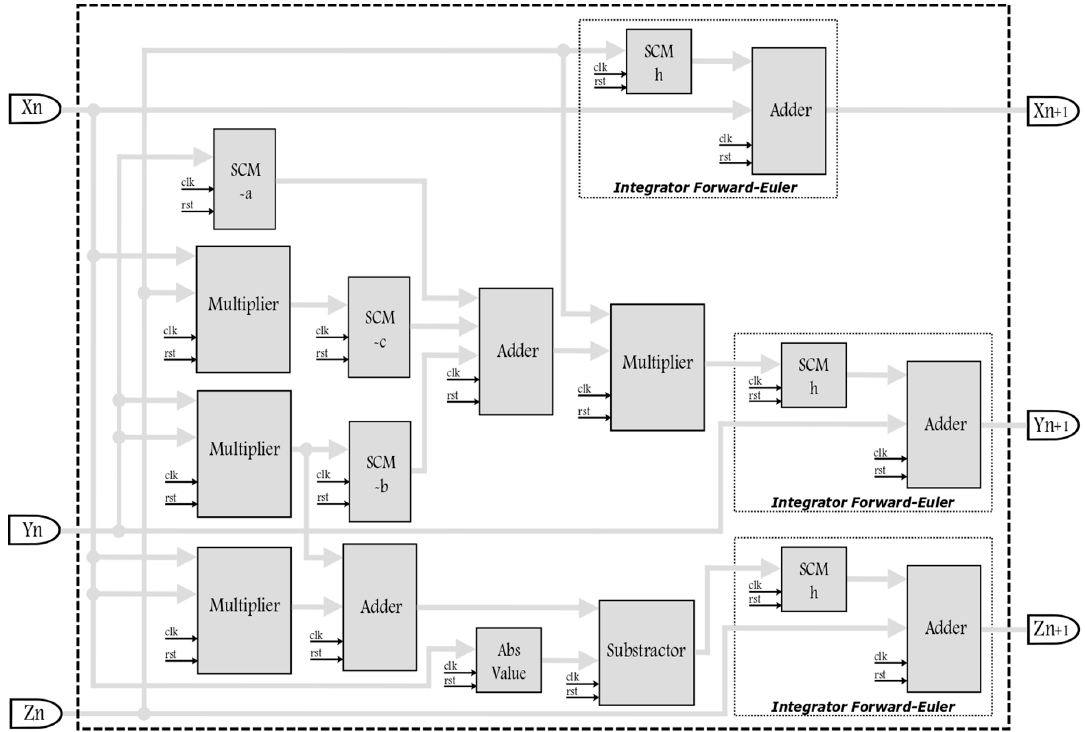
Figure 9. Block description of the new chaotic system given in System (1), discretized with Forward-Euler. Table 2. Resources using the FPGA Cyclone IV EP4CGX150DF31C7 for implementing System (2) applying Forward-Euler and fourth-order Runge-Kutta methods.